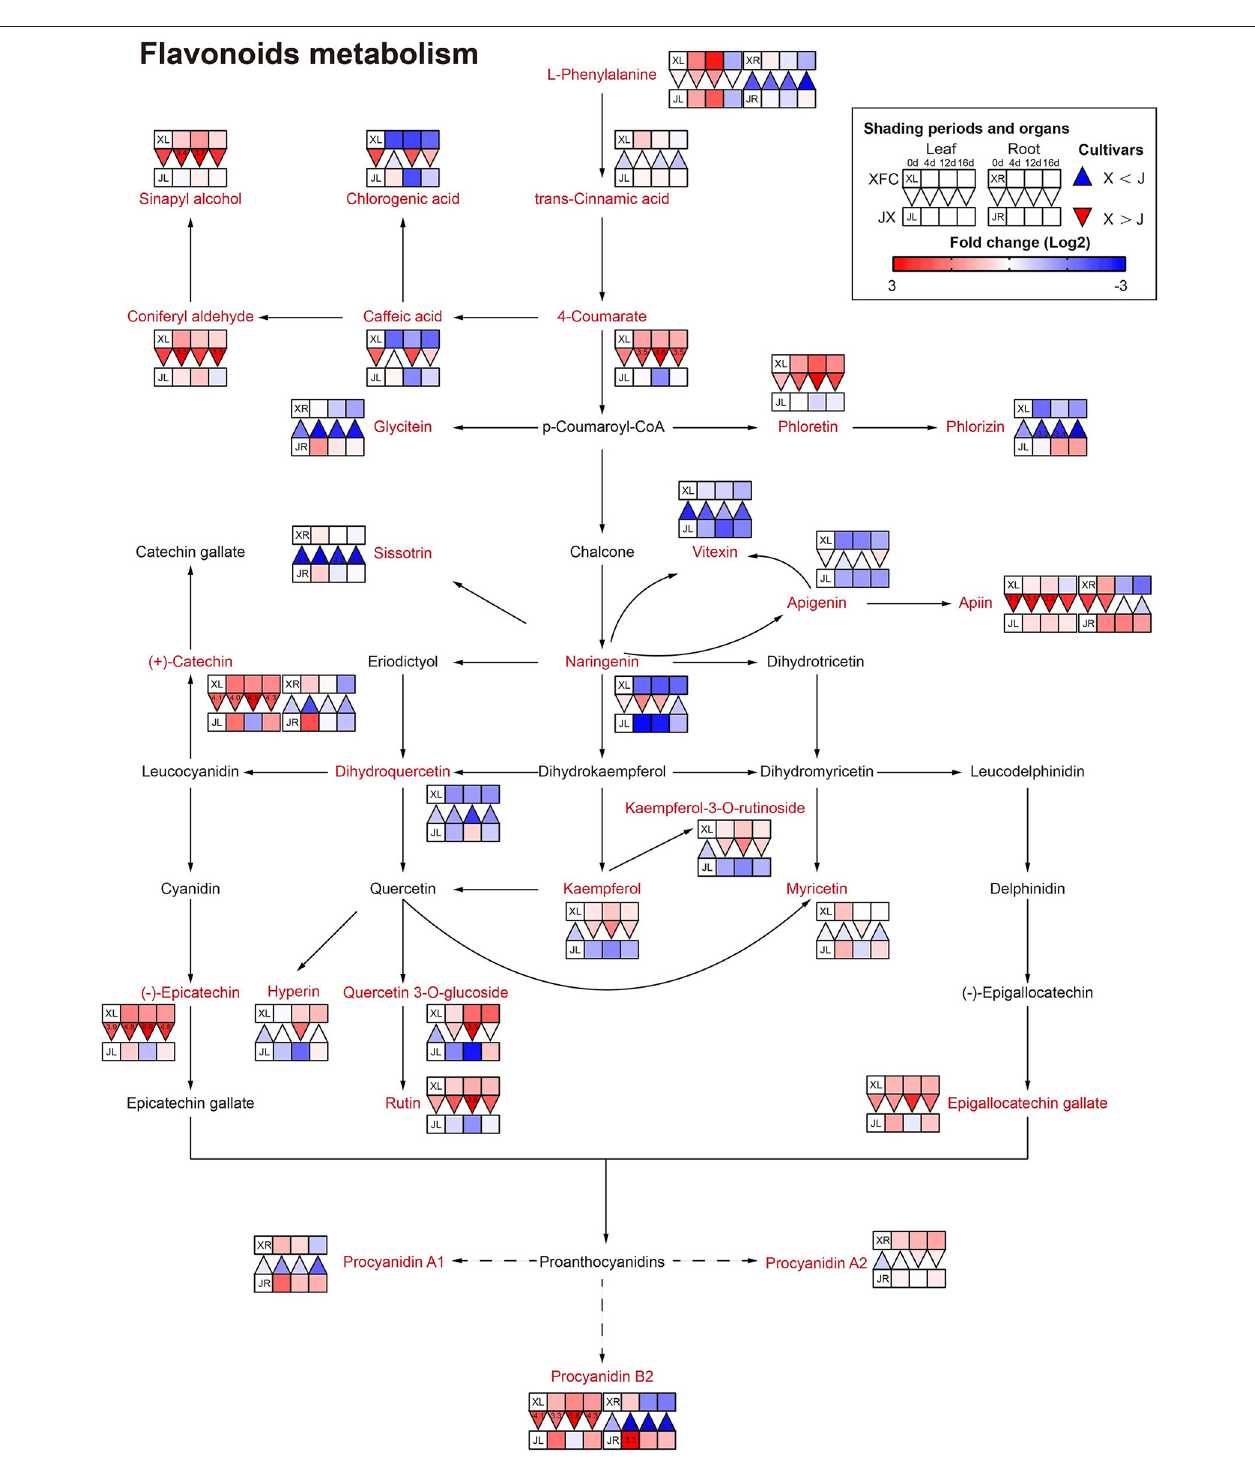
FIGURE 9 | The metabolite differences during flavonoids metabolism in the two tea cultivars under different shading periods. The identified metabolites are marked with a red color. In the legend, the squares at two lines express the different cultivars, “Xiangfeicui” (XFC) and “Jinxuan” (JX). The squares at eight columns express the different shading periods. The squares in the left part represent the leaves and the right part represents the roots. Blue indicates relatively low and red indicates relatively high intensity. The red triangle indicates relatively higher intensity of metabolites in XFC (X) than in JX (J), and the inverted blue triangle indicates relatively lower intensity of metabolites in XFC (X) than in JX (J). The degree of change was described with the depth of color, and the depth of the colors is based on the log2-fold change value between the samples. XL, leaf of “Xiangfeicui”; XR, root of “Xiangfeicui”; JL, leaf of “Jinxuan”; JR, root of “Jinxuan”.